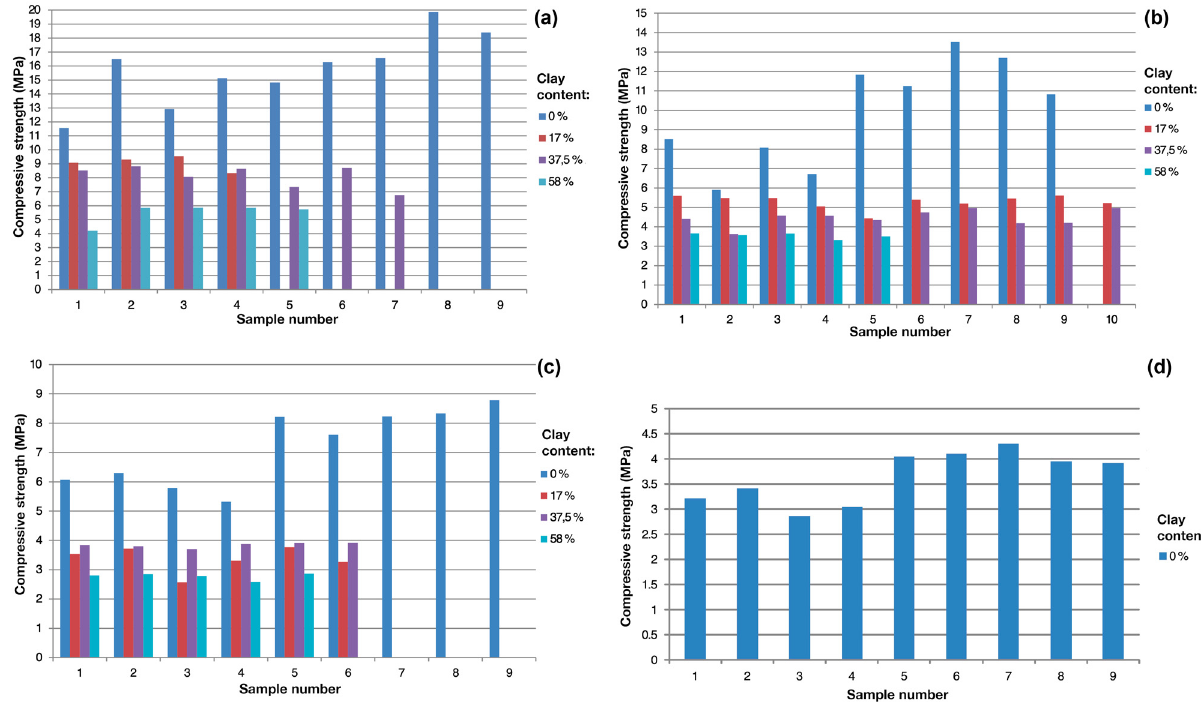
Figure 13: Compressive strength of sample stabilised with various binder recipes with di ff erent admixtures of clay during 28 days at 20 ° C . ( a ) CEM II/A - M; ( b ) 70% CEM II/A - M and 30% LKD; ( c ) 80% CEM II/A - M and 20% CKD; ( d ) 70% CEM II/A - M and 30%